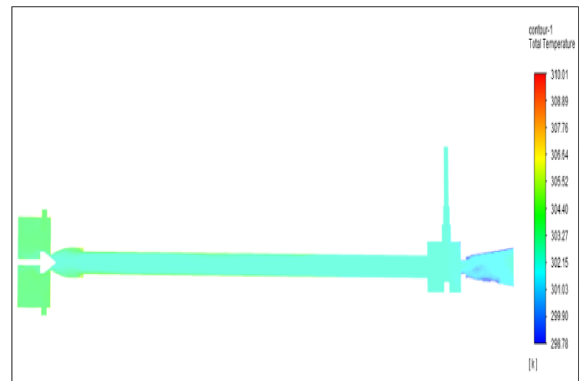
Figure 47. Acrylic at 12 bar.